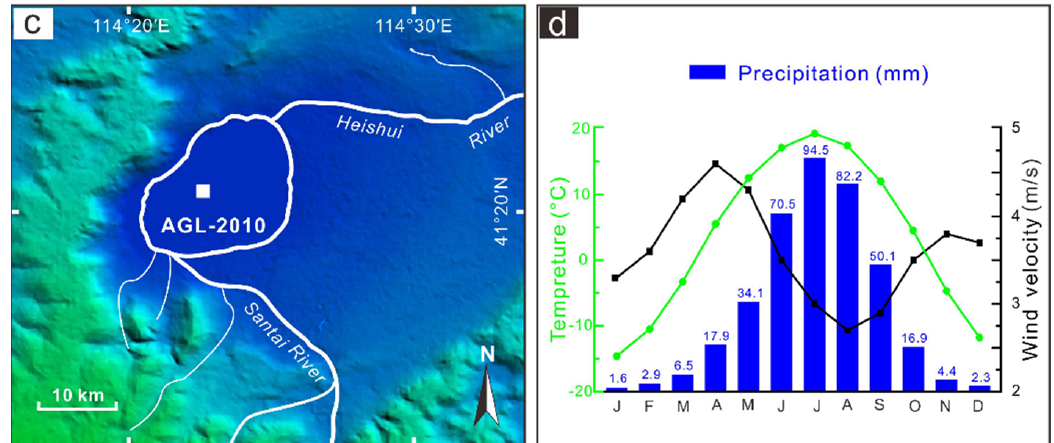
Figure 1. ( a ) Map of the study region in China. EASM is the East Asian summer monsoon, EAWM is the East Asian winter monsoon, and ISM is the India summer monsoon. The modern Asian summer monsoon limit is shown by the dashed green line. ( b ) Map of the Anguli-nuur lake region and the Otindag Sandy Land. ( c ) Map of the location of core AGL-2010. ( d ) Monthly mean precipitation, temperature, and wind velocity for the Zhangbei County meteorological station from 1981 to 2010 (http://data.cma.cn/ (accessed on 10 November 2021).